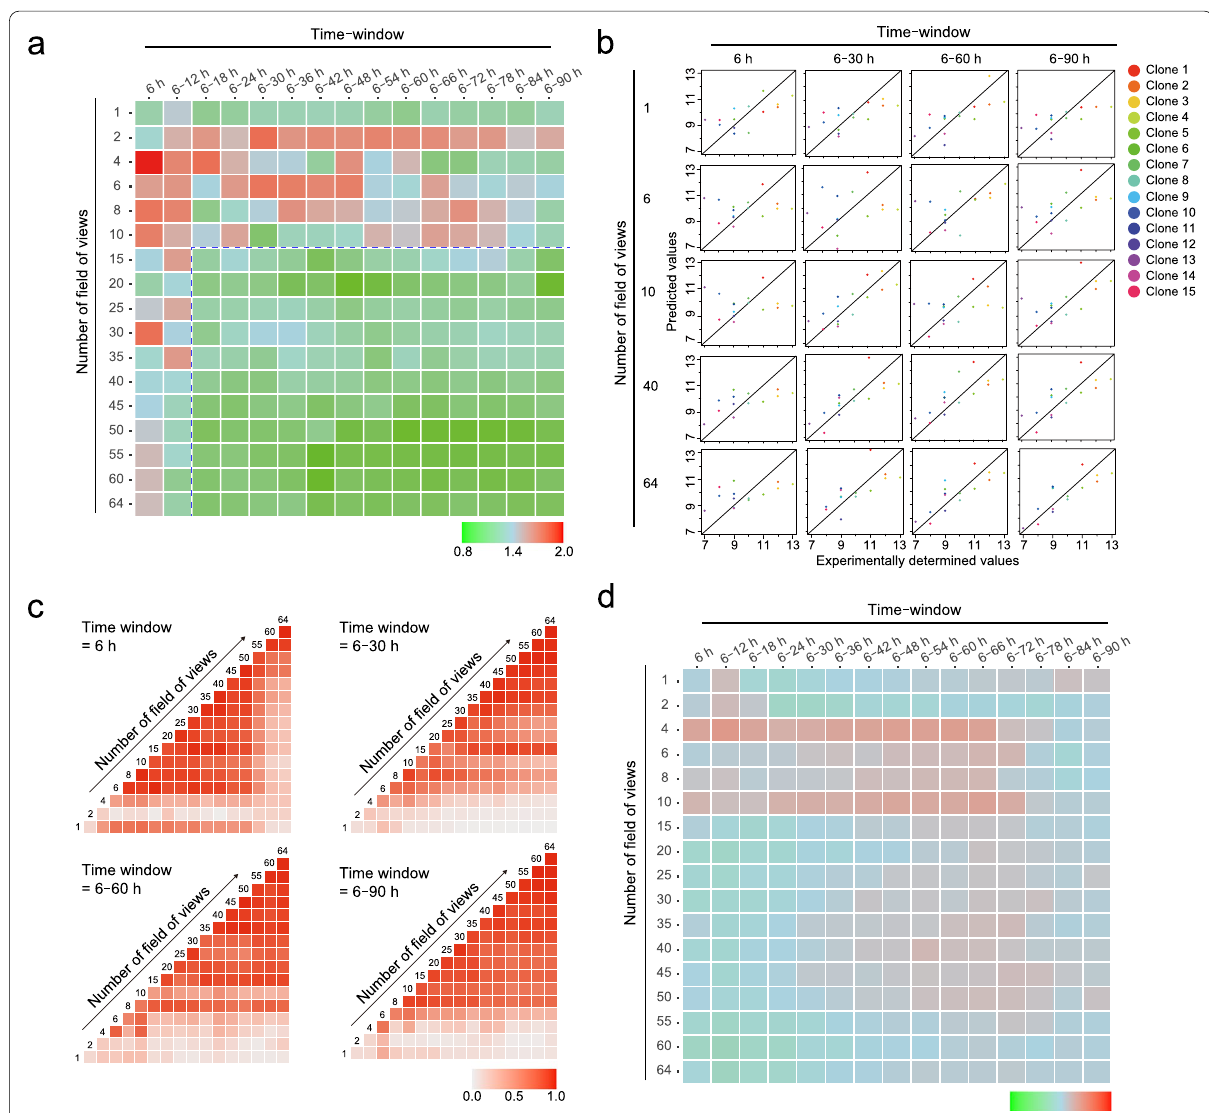
Fig. 4 Exhaustive evaluation of the data-usage effect and performances of serial-passage prediction models. a Evaluation of data-usage effect with LASSO. The row values represent the number of FOVs used, and the column values represent the time-window size used for training data. The heatmap indicates the RMSE. RMSE < 1.0 is considered a good performing model. b Scatter plots to visualize the serial-passage prediction model performances; each dot represents one clone. c Comparison of model structures between two pairs of constructed models in a . Time windows of 6, 6–30, 6–60, and 6–90 h were selected. The heat map indicates the correlation coefficiencies between all weights on all selected morphological descriptors in the model. The correlation coefficiencies become high if the used descriptor combination is similar. d Evaluation of the data-usage effect with RF; the row indicates the number of FOVs used, and the column represents the time-window size used for training data. The heatmap indicates the RMSE. RMSE < 1.0 is considered a good performing